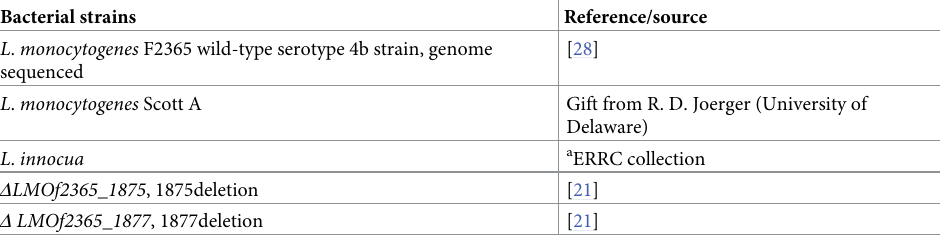
Table 1. Listeria strains used in this